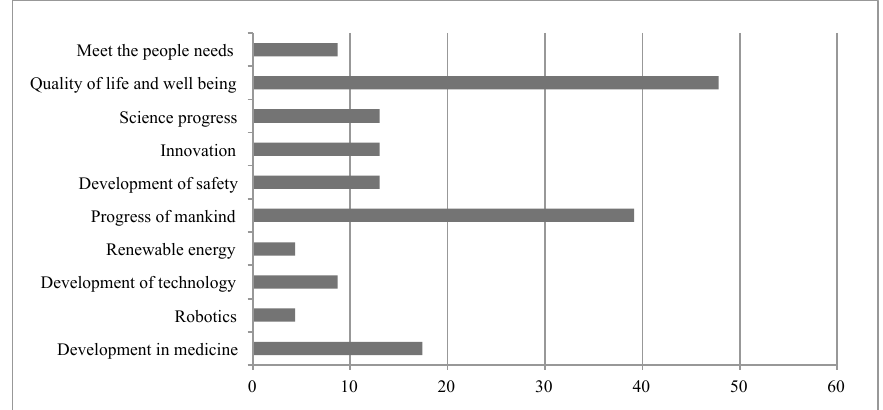
Fig. 2. Answer to the open question about the best impact/influence of engineering in society (% of total